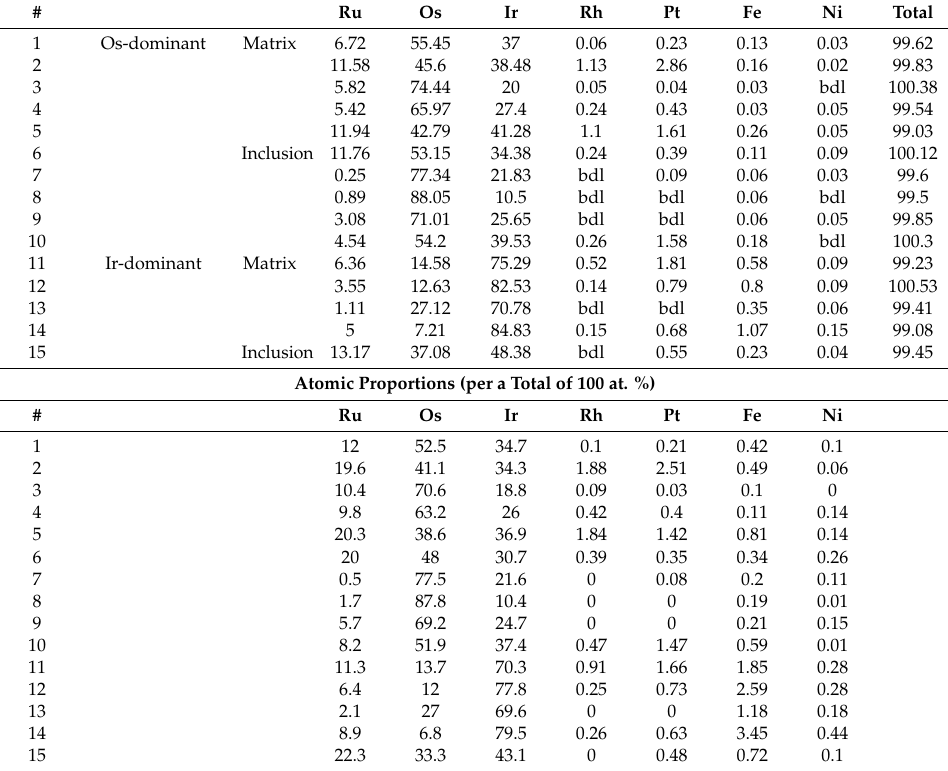
Table 2. Compositions of Os–Ir–Ru alloy minerals from the Sisim placer zone, Eastern Sayans.